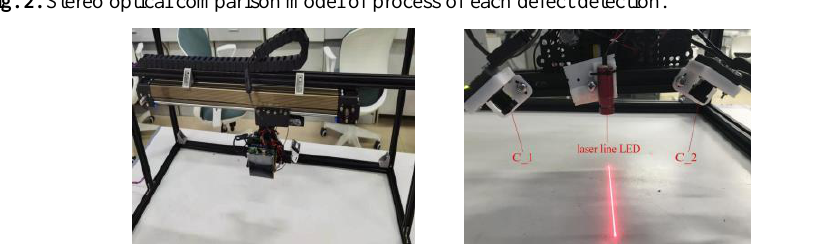
Fig. 3. X-Y axial frame of experimental system. Fig. 4. Stereo comparison detection